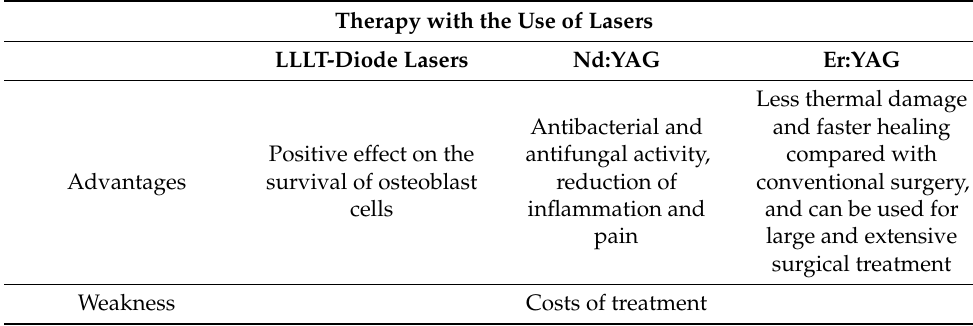
Table 2. Non-surgical therapy with the use of lasers. LLLT, low-level laser therapy. Therapy with the Use of Lasers LLLT-Diode Lasers